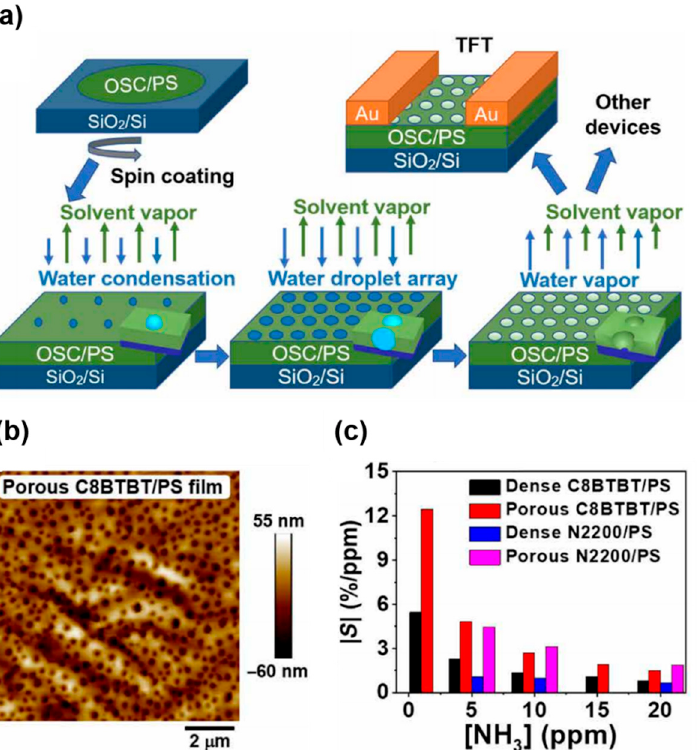
Figure 9. ( a ) Fabrication procedure for a porous organic semiconductor film, ( b ) atomic force mi- croscopy image of a porous C8-BTBT/polystyrene (PS) film, and ( c ) sensitivities of FETs-based gas sensors based on dense/porous C8-BTBT/PS and poly [N,N ′